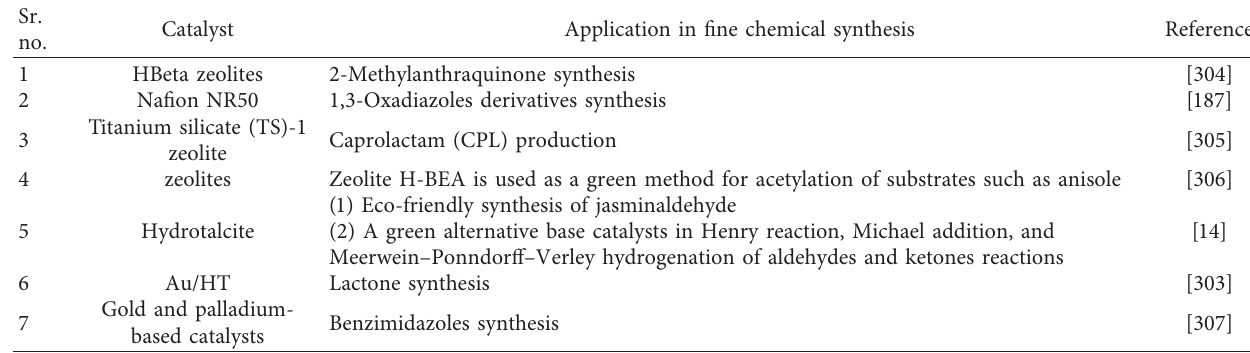
Table 12: Catalysts and their respective application in fine chemical